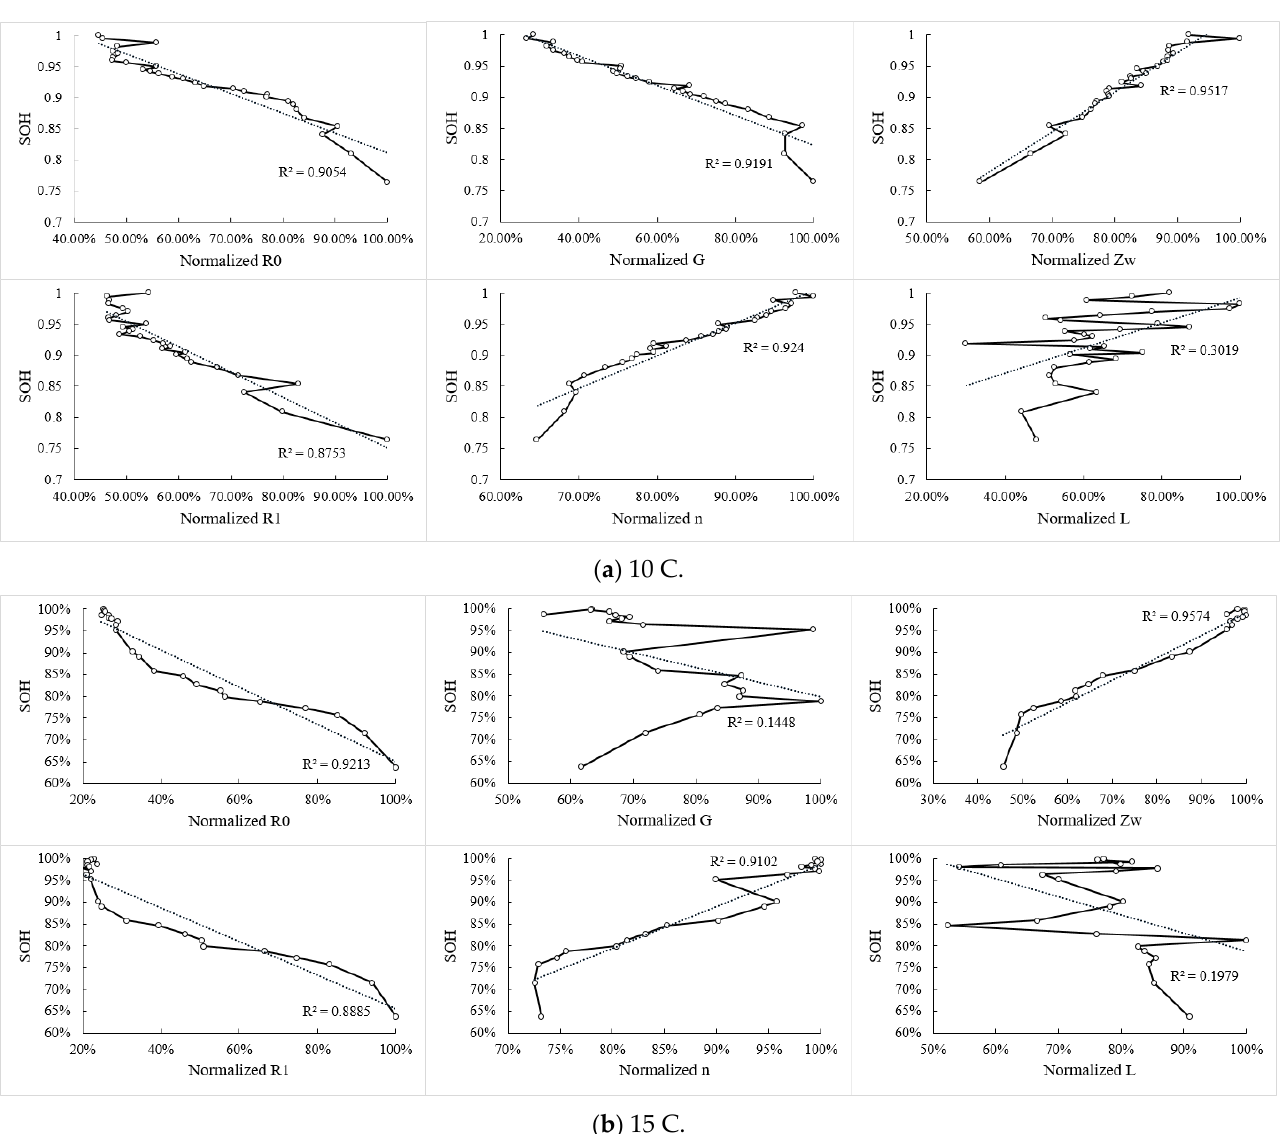
Figure 5. The relationship between the SOH and normalized battery parameters at two different discharge rates.